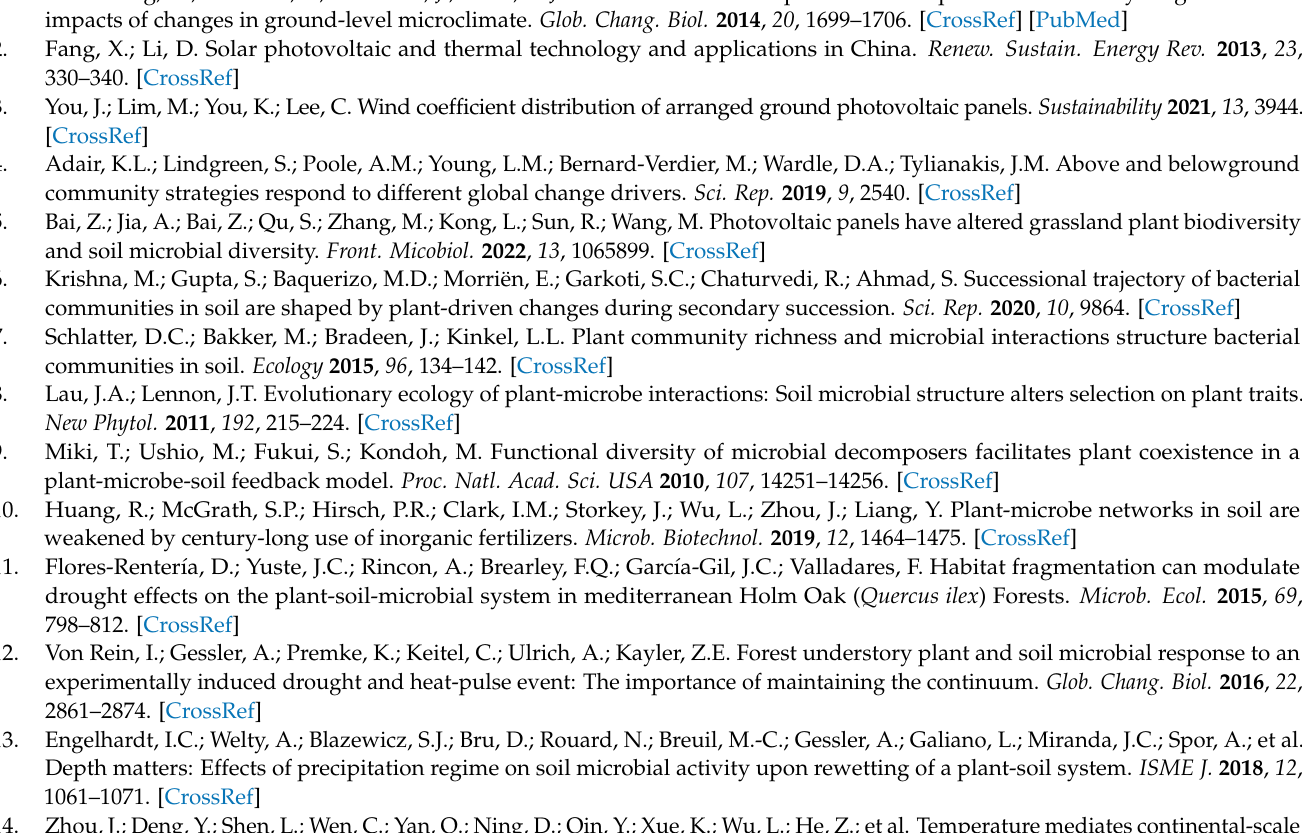
paper. Table S2: Effects of photovoltaic panel shading on plant species composition and important values. Table S3: Correlation between environmental factors and plant diversity and aboveground biomass. Table S4: Correlation between environmental factors and fungal diversity. Table S5: Properties of network in Figure 10. Table S6: List of key species in co-occurrence network of S and NS treatments. Figure S1: Differences in the relative abundance of the dominant bacterial order between S and NS treatments. Figure S2: Differences in the relative abundance of the dominant fungal order between S and NS treatments. Figure S3: Differences in the relative abundance of the dominant protist order between S and NS treatment. Figure S4: Relationship between plant diversity and soil microbial community